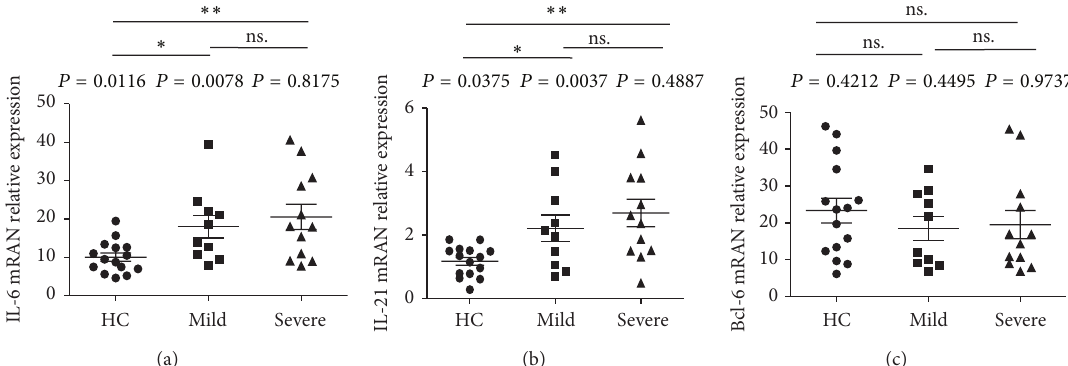
Figure 6: Expression of IL-6, IL-21, and Bcl-6 mRNA in human PBMCs. Human PBMCs from 10 mild and 12 severe patients with EV71 infection, and 15 HC were detected by real-time PCR assay as described in Section 2. (a) The levels of IL-6 mRNA in human PBMCs. (b) The levels of IL-21 mRNA in human PBMCs. (c) The levels of Bcl-6 mRNA in human PBMCs; data shown were the mean ± SD. The horizontal lines show the median. ∗ 𝑃 < 0.05 ; ∗∗ 𝑃 < 0.01 ; ∗∗∗ 𝑃 < 0.001 ; ns.: no significant